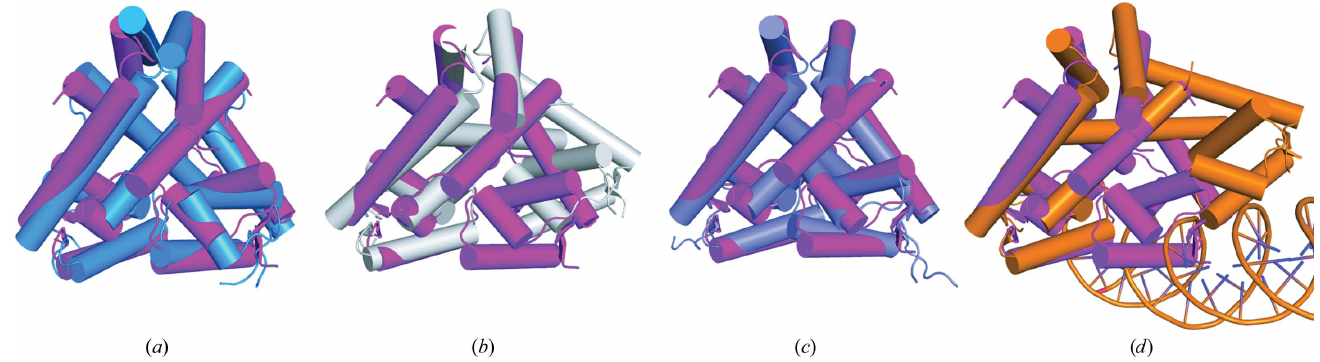
Figure 5 Structural comparison between Pa MarR and Mt MarR. The structure of Pa MarR (magenta) is superimposed onto those of ( a ) native (marine), ( b )